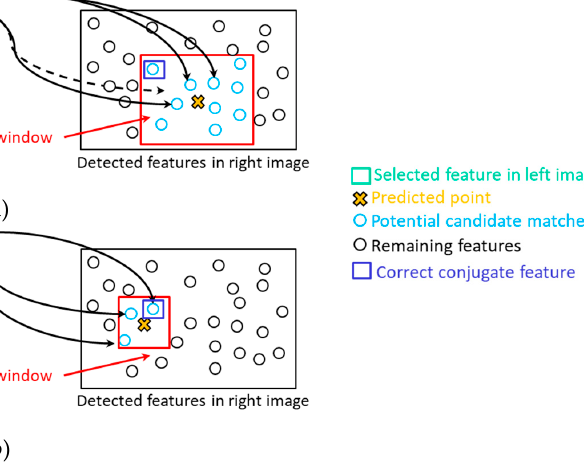
Figure 15. Rotation-constrained image matching: ( a ) predicted point location and matching search window size in first iteration and ( b ) progression of the matching evaluation through the iterations.